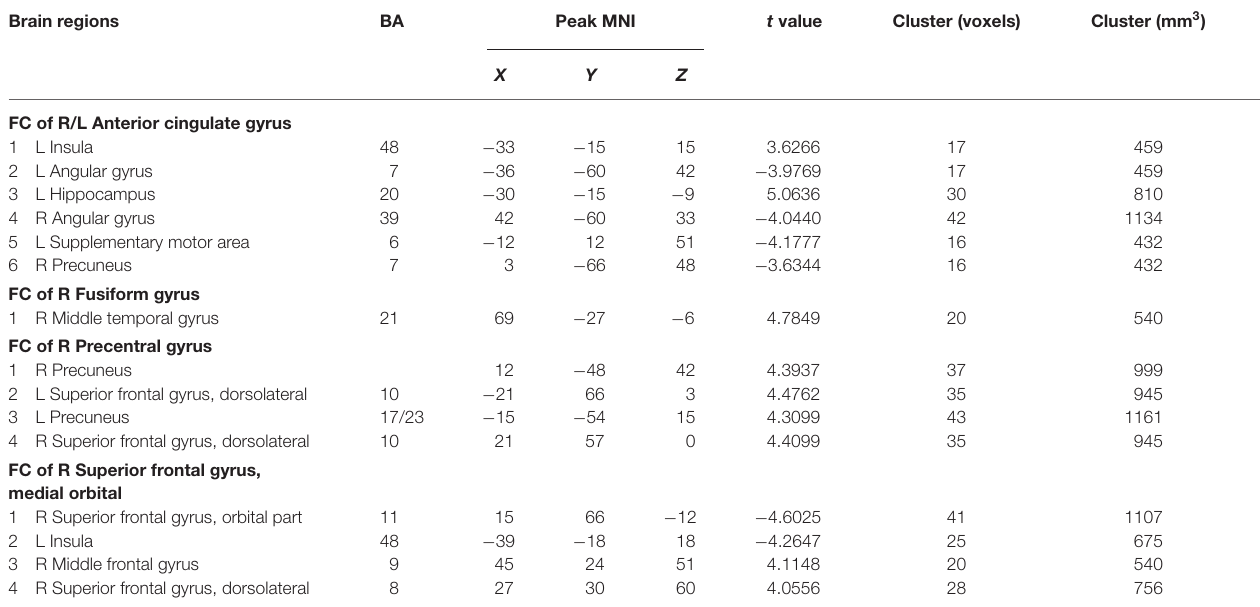
TABLE 4 | Brain regions with different functional connectivity (FC) between T2DM patients and healthy control groups. Brain